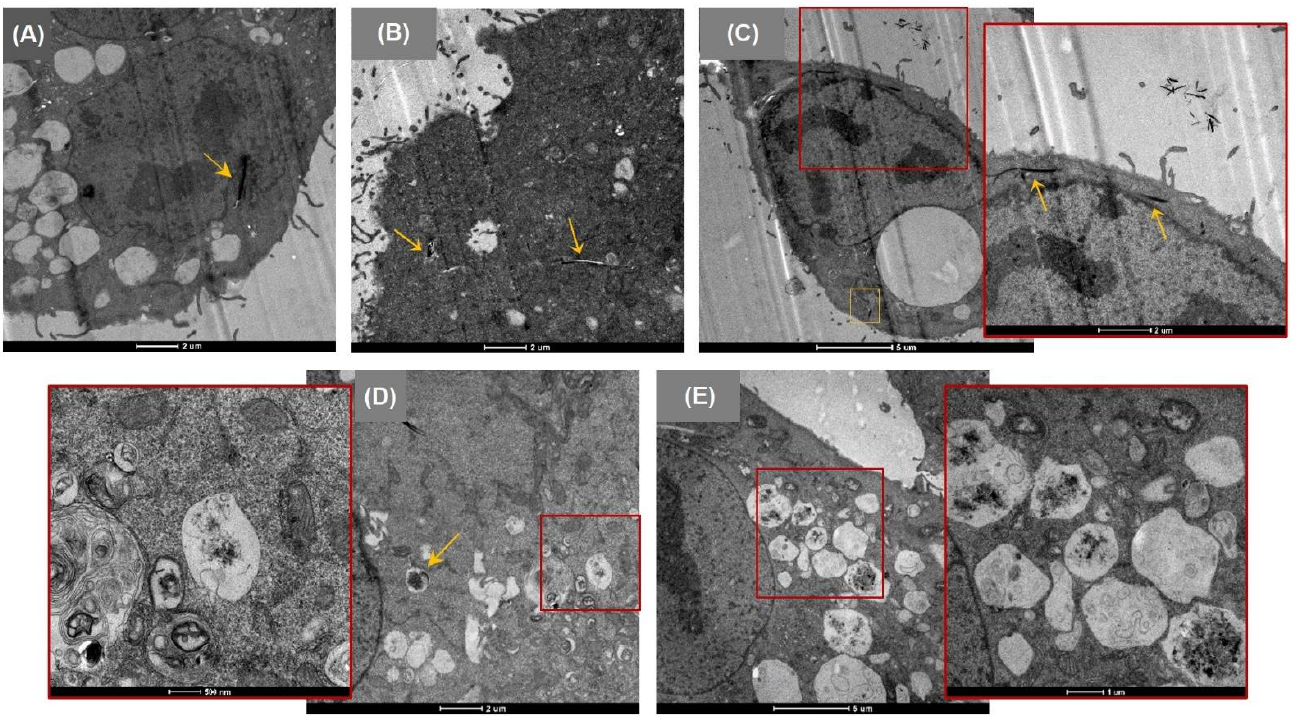
Figure 4. Representative TEM images of A549 cells after 24 h exposure to the MWCNT under study (25 μg/cm 2 ). ( A – C ) NM-401 exposed cells; ( D , E ) NM-402 exposed cells; Yellow arrows indicate the location of the CMNM uptake.